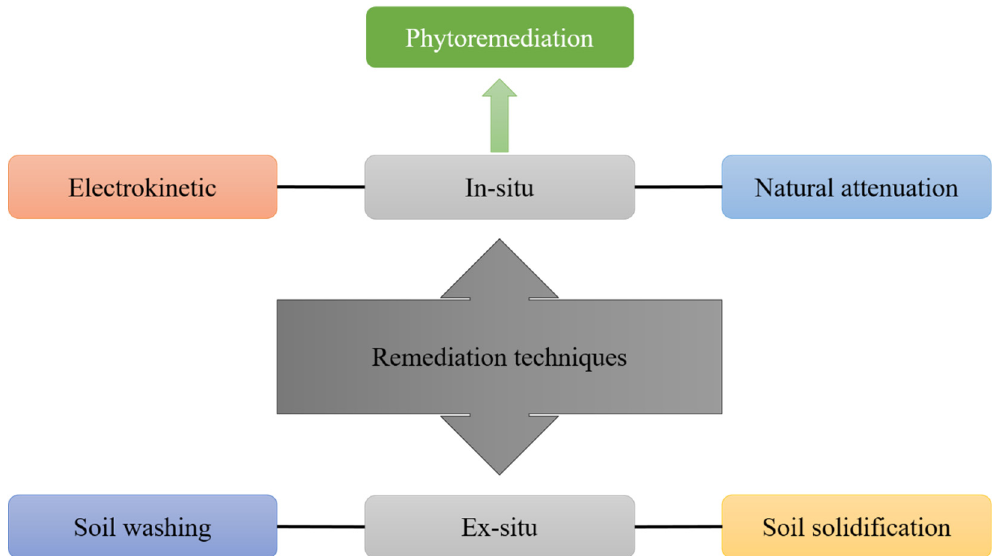
Figure 4. Classification of basic remediation approaches.